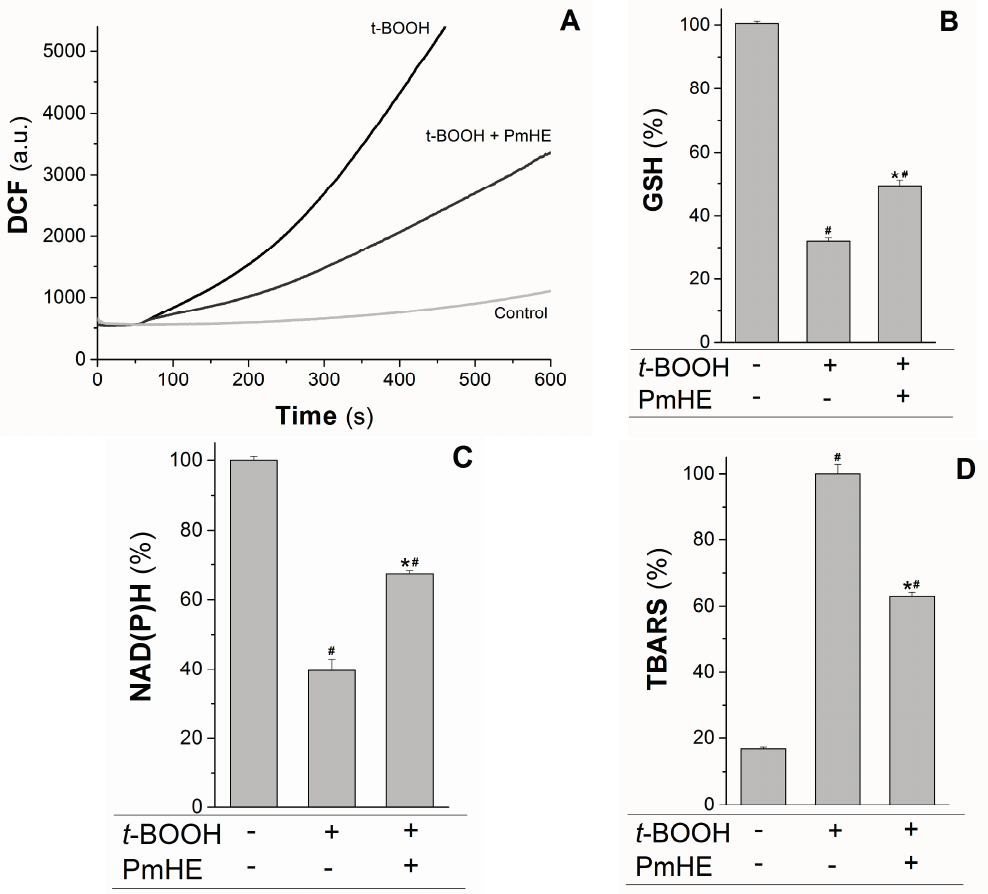
Figure 3. Protective effects of P. major hydroethanolic extract in isolated rat liver mitochondria exposed to the oxidant t -BOOH. Mitochondria (1 mg/mL) were incubated with PmHE (0.1 mg/mL) in the presence of 0.6 mM t -BOOH. ( A ) ROS (reactive oxygen species) generation was accompanied by monitoring DCF (2 ′ ,7 ′ -dichlorodihydrofluorescein) fluorescence at 503/529 nm excitation/emission, respectively; traces are representative of (at least) three experiments with different mitochondrial preparations; ( B ) GSH (glutathione, reduced form) and ( C ) NAD(P)H levels measured fluorimetrically, as described in Materials and Methods. Data were presented as the mean of three experiments with different mitochondrial preparations; ( D ) Lipid peroxidation was as TBARS. Percentages were calculated by considering positive control as 100% and data were presented as mean ± S.E.M. of three experiments in triplicate with different mitochondrial preparations. * Statistically different from t -BOOH, and # statistically different from control ( p <